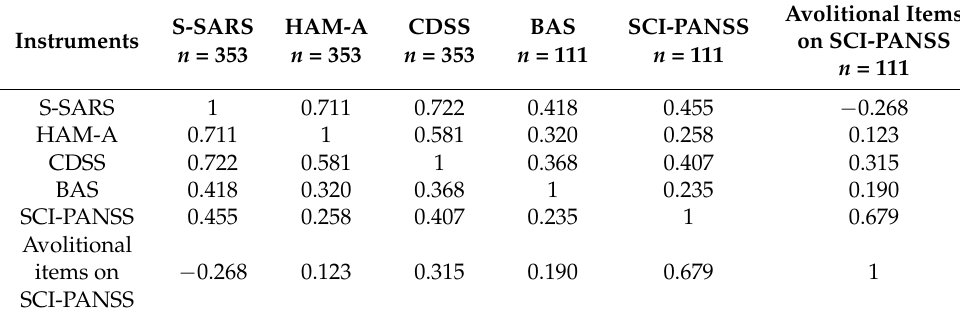
Table 4. Pearson’s correlation coefficients among the measures in combined data